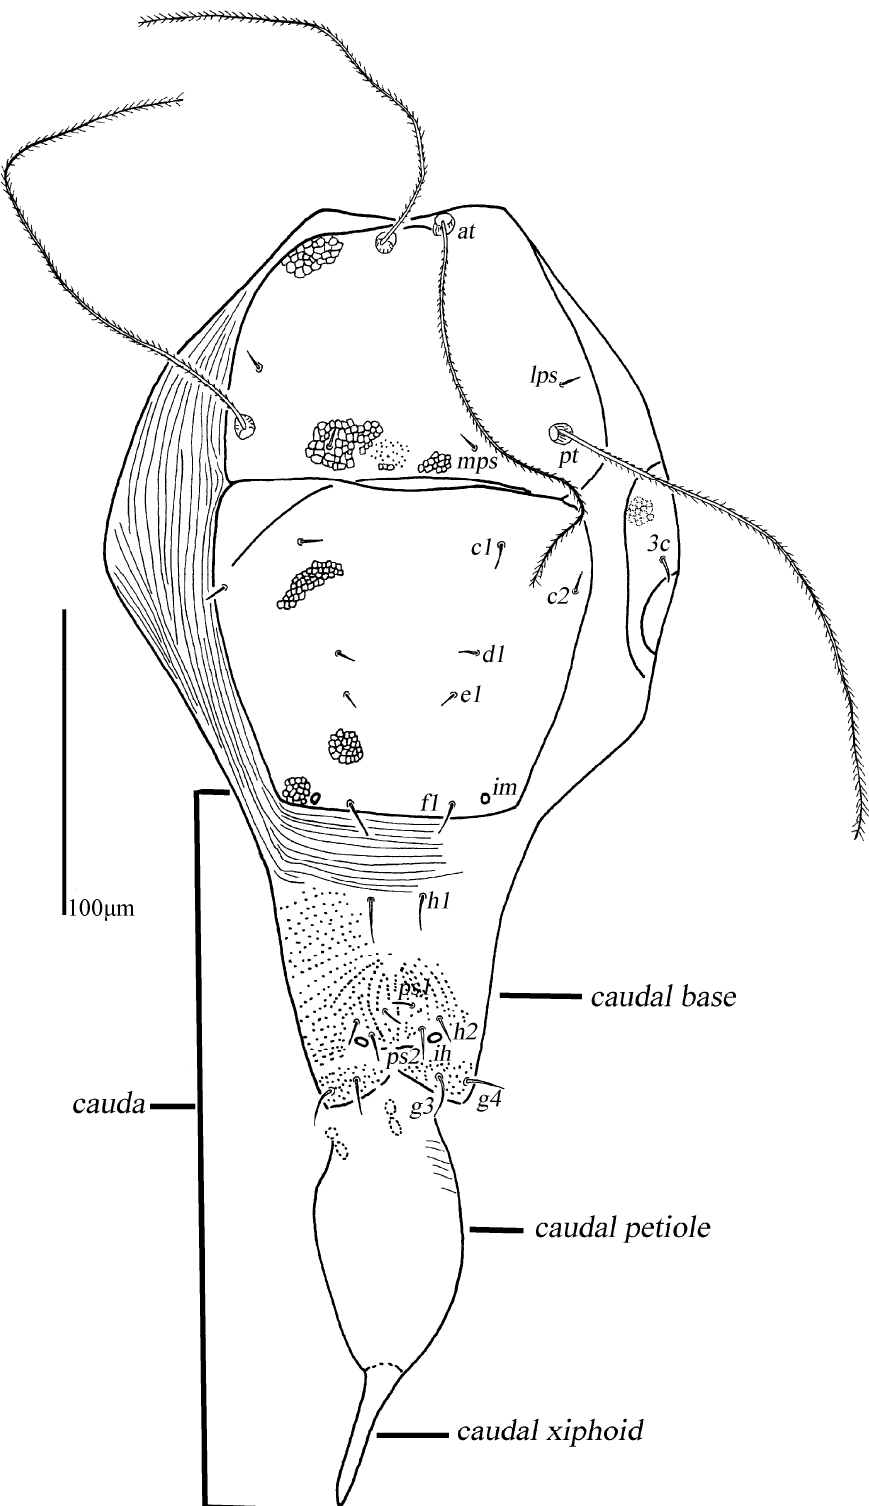
Figure 9. Cunaxicaudus neomohanensis sp. nov . (male). Dorsal idiosoma. Scale bar = 100 µm.